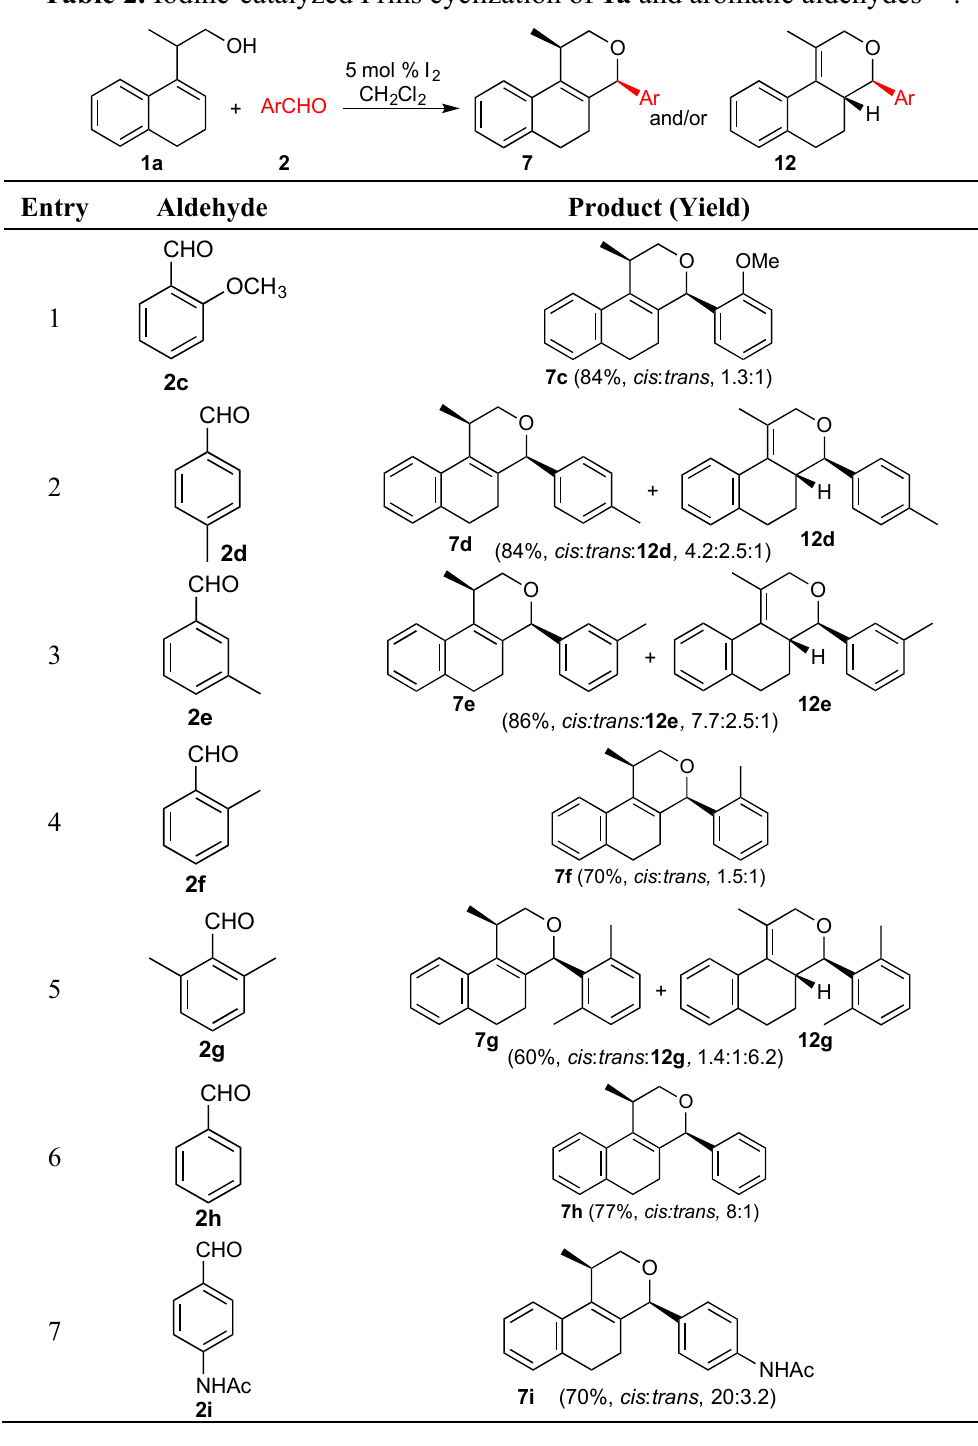
Table 2. Iodine-catalyzed Prins cyclization of 1a and aromatic aldehydes a,b